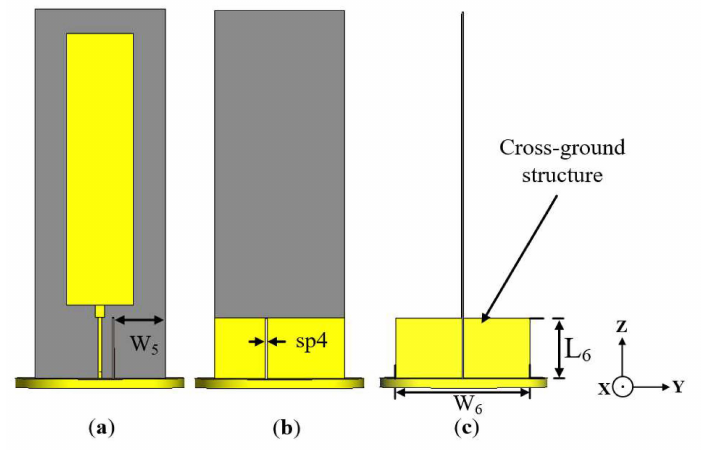
Figure 3. Geometry of the conventional antenna incorporated with cross-ground structure: ( a ) front view, ( b ) back view, and ( c ) side